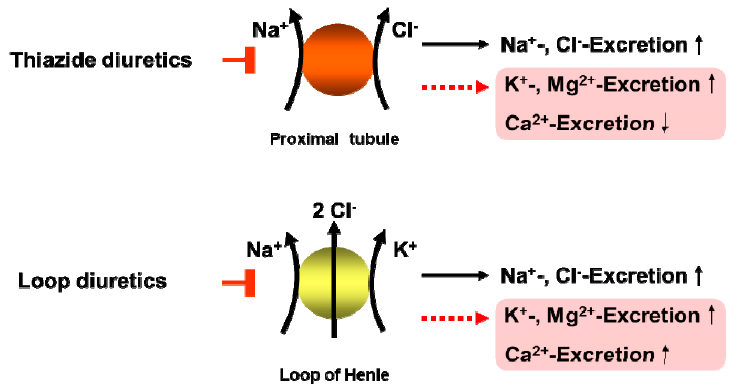
Figure 2. Electrolyte disorders by thiazides and loop diuretics